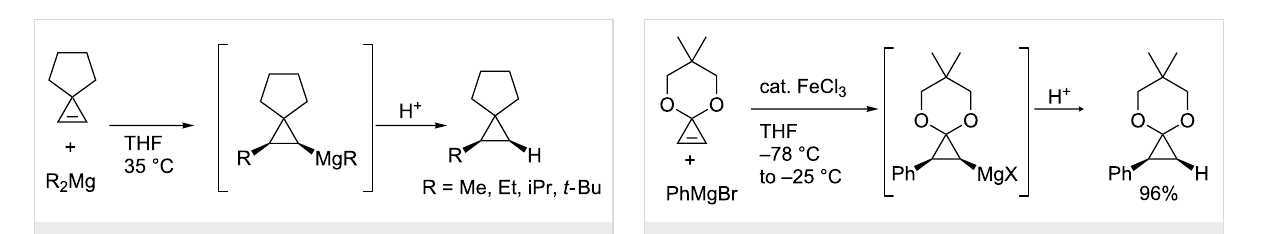
Scheme 16: Uncatalyzed carbomagnesiation of cyclopropenes. Scheme 17: Iron-catalyzed carbometalation of